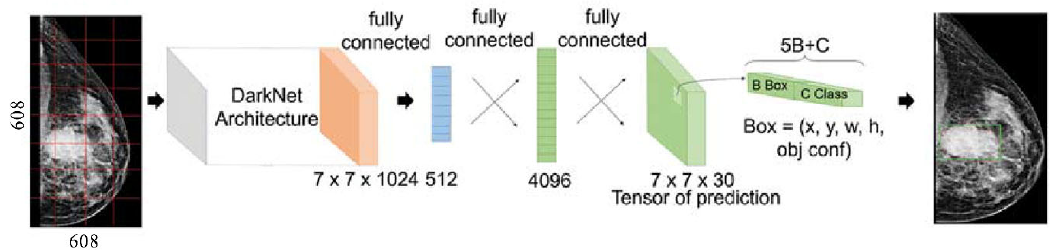
Figure 1. The YOLOv4 architecture with DarkNet framework.